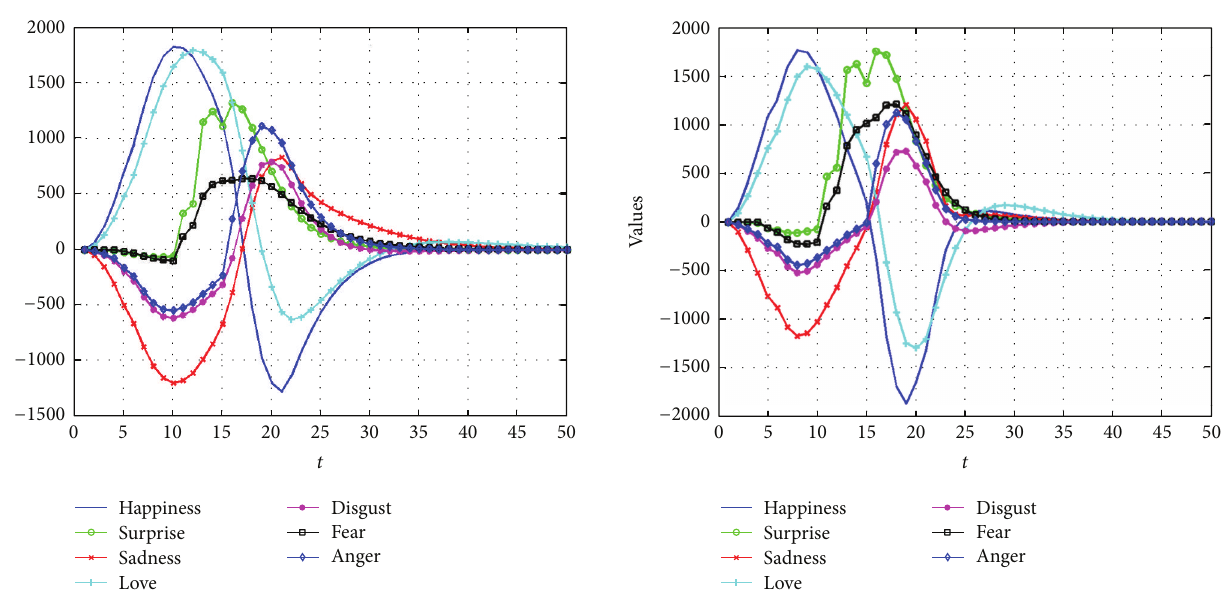
Figure 5: Graph of emotions generated by young females.